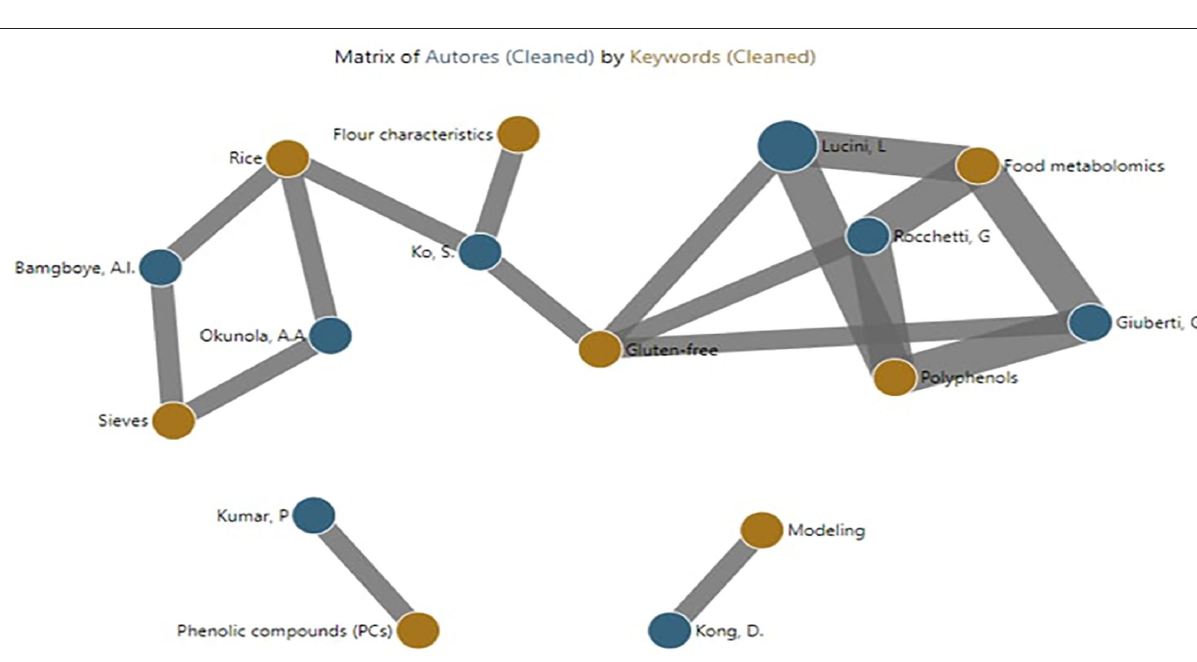
represent some of the trends on which future research can be